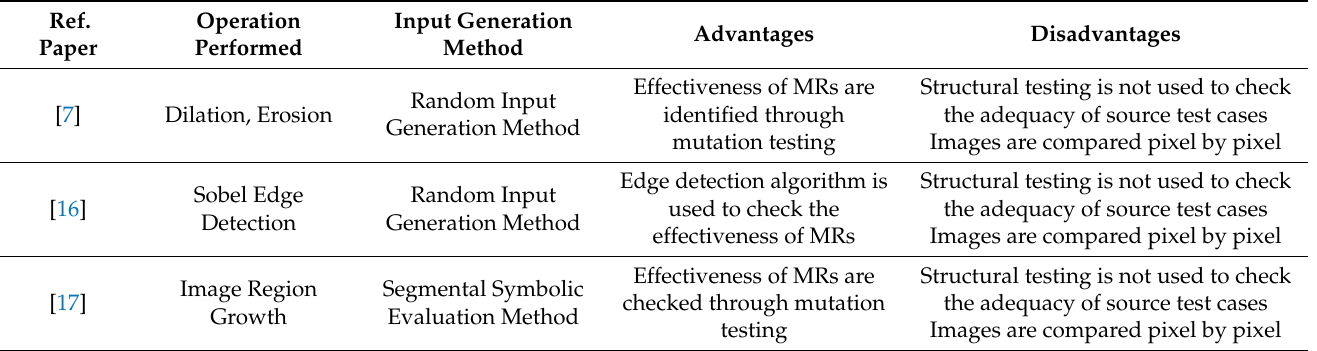
Table 1. Summary of papers related to metamorphic testing in